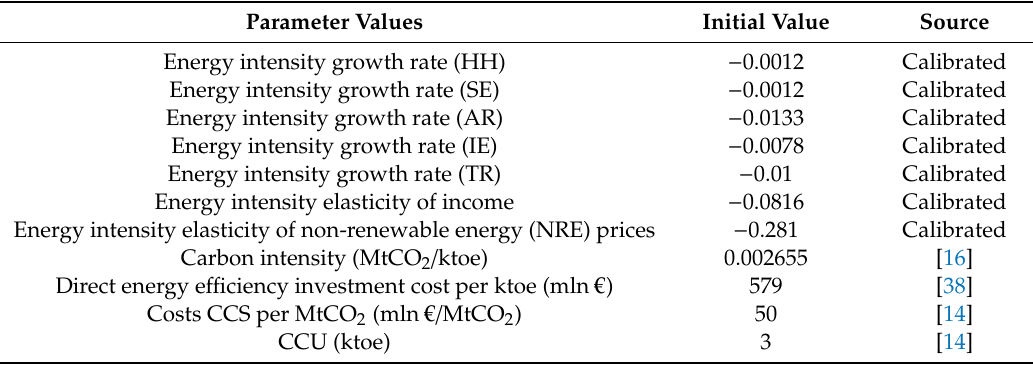
Table 3. Parameter values of the energy sub-system.